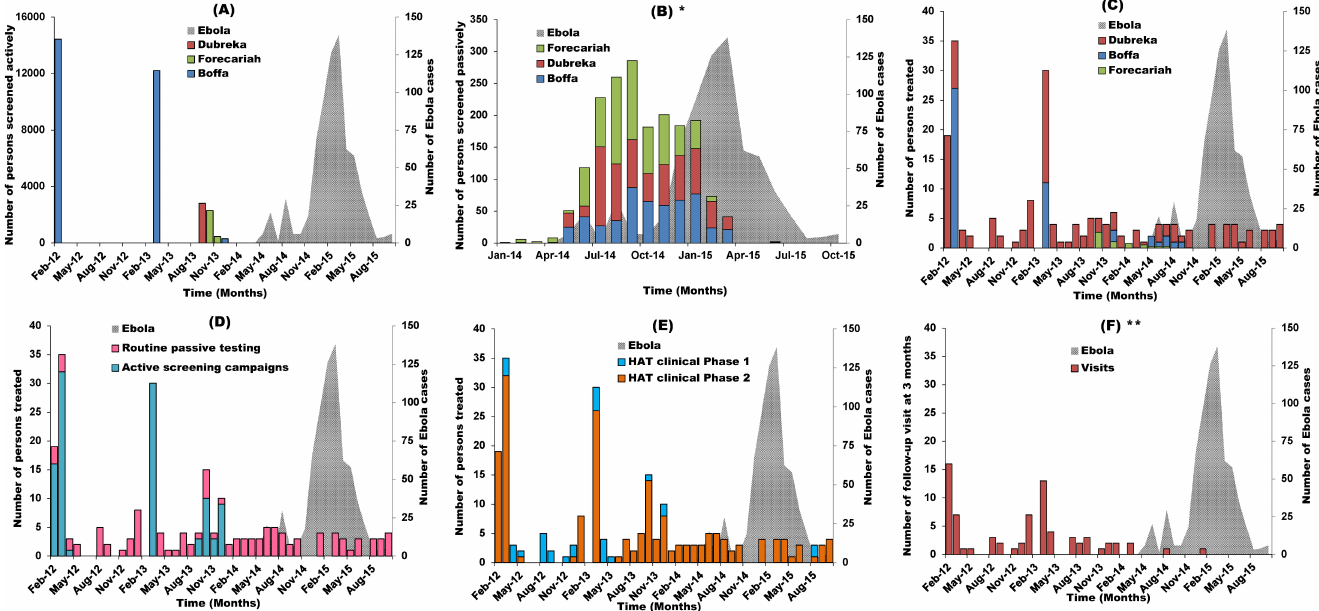
Fig 3. Impact of Ebola outbreak on HAT testing and caring activities in Guinea, January 2012 to October 2015. This panel figure displays: (A) Monthly evolutionof the numberof personsdiagnosedduringactive campaignsby HAT treatment center; (B) Monthly evolutionof the numberof persons tested passivelyby HAT treatment center (and as from 2014 corresponding district); (C) Monthly evolutionof the numberof personsinitiatingtherapy by HAT treatment center; (D) Monthly evolutionof the number of personsinitiatingHAT therapy accordingto the type of screening; (E) Monthly evolutionof the number of personsinitiatingHAT therapy by disease stage at diagnosis (F) Monthly evolutionof the number of personsattending 3 months post- treatment follow-upvisit. HAT: Human African Trypanosomiasis: * Passiveroutine testing data were availableonly between January2014 and October 2015. ** Allpost-treatment follow-upvisits were centralized at the Dubrekacenter whatever the place where the patients received HAT therapy (Dubreka, Boffa or Forecariah HAT centers).